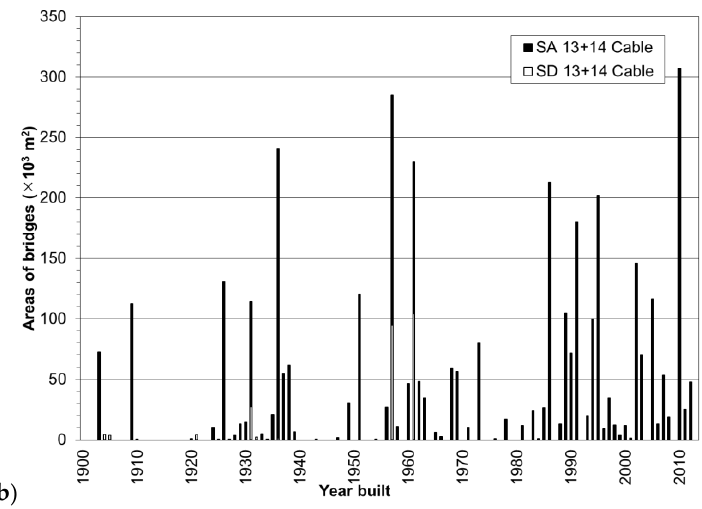
Figure 6. Distribution and SA to SD ratio of cable (types 13 and 14) bridges. (a) Counts and (b) Areas.